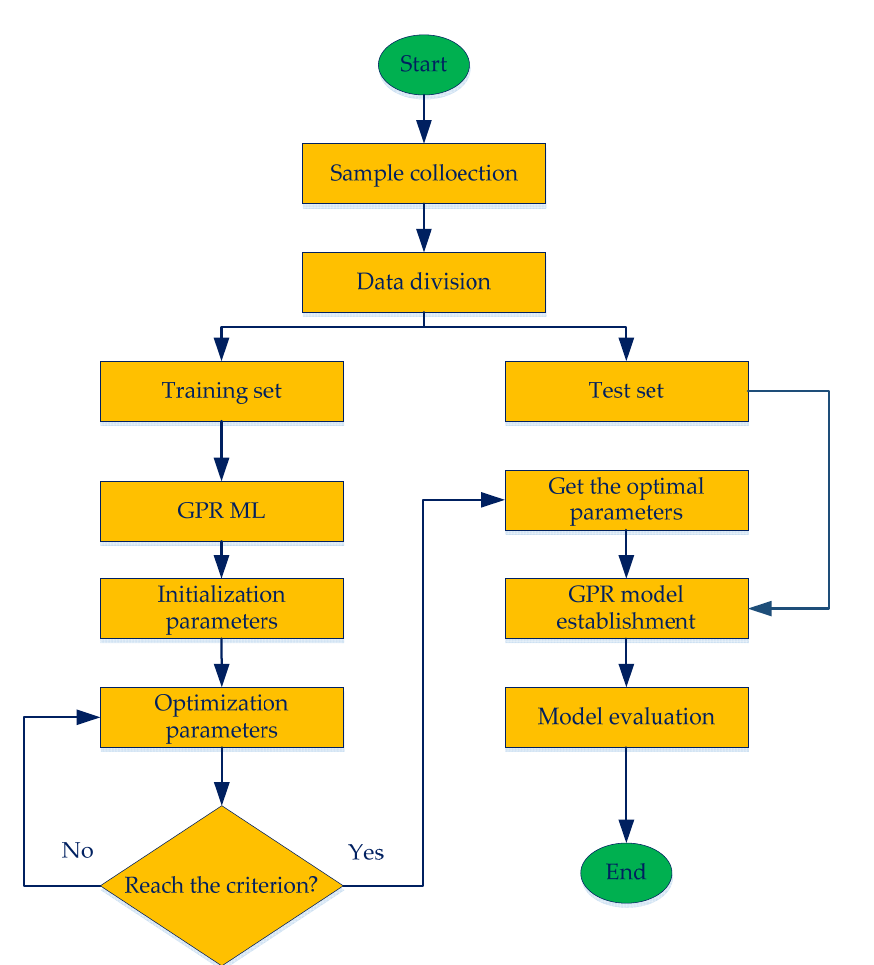
Figure 1. The flowchart associated with the prediction of ultimate bearing capacity using a data- driven